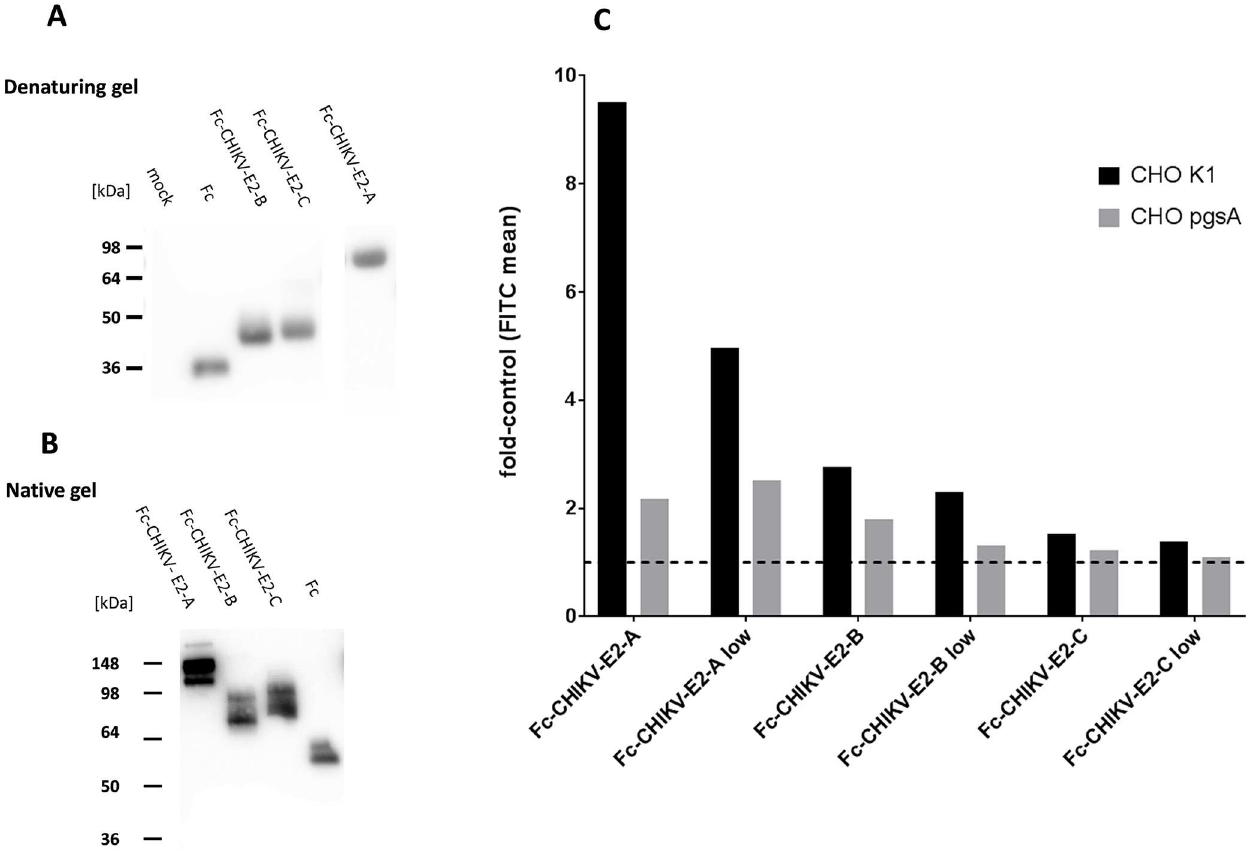
Fig 7. Binding of recombinantFc-fusion proteins containing CHIKVE2 domains A, B, and C to CHO-K1and pgsA-745cells. A: Fc-E2- fusionproteinsandFc proteinwereexpressedfrom HEK293Tcells,affinity purifiedby protein-Achromatographyandseparatedby SDS-PAGE underreducingconditions. The Westernblot was detectedwithan HRP-labeled anti-human IgG antibody.Thecalculatedmolecular weightsare: Fc 29.2kDa; Fc-CHIKV-E2-B 35,0kDa; Fc-CHIKV-E2-C37.1kDaandFc-CHIKV-E2-A 53 kDa.B: Separation of theFc-fusionproteinsundernative conditions. The Westernblot wasdetectedwithan HRP-labeledanti-humanIgG antibody.C: CHO-K1(black)andpgsA-745(grey)cells were incubatedwiththe indicated recombinantFc-fusionproteinsas singlemeasurements. Bindingwasmeasured by flowcytometry usingan anti-human IgG FITC conjugatedantibody. The resultsareshownas fold inductioncompared to Fc binding.Two volumeswereuse either400 μ lor 100 μ l(low). A valueof onerepresentsthe meanFITC valueof the controlandis labeledby the dashedline.Valuesabovethis lineindicatebinding.Data representan averageexperiment of threeindependent experiments